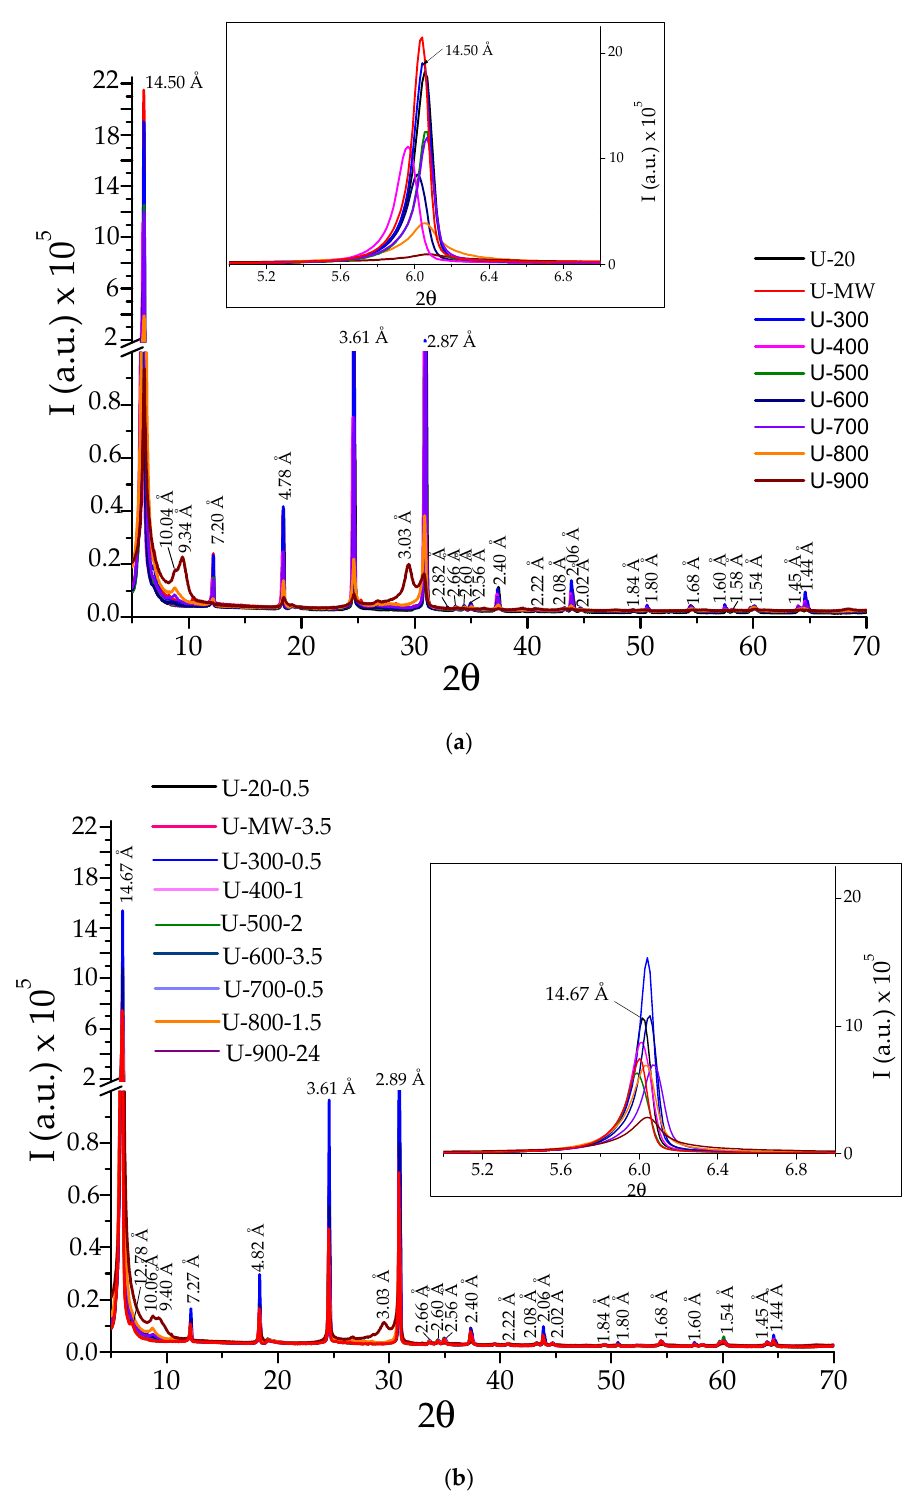
Figure 5. X-ray diffraction patterns of the pristine and treated samples.: ( a ) Pristine and expanded samples; in the inset X-ray diffraction patterns showing the principal reflection 002 at 14.50 Å. ( b ) Pristine and expanded samples after immersion in water; in the inset X-ray diffraction patterns showing the principal reflection 002 at 14.67 Å.